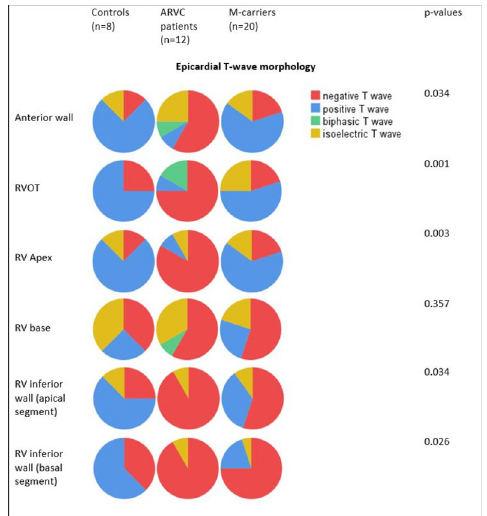
Fig 5. Epicardial repolarisation morphology as reflected by T wave morphology per study group and area of interest. The figure summarizes the morphology of the epicardial T-waves, per study group and area of interest. The size of the pie chart reflects its proportional size. The p-values refer to the comparison between the three study groups with Kruskal-Wallis test. RV = right ventricle, RVOT = right ventricle outflow